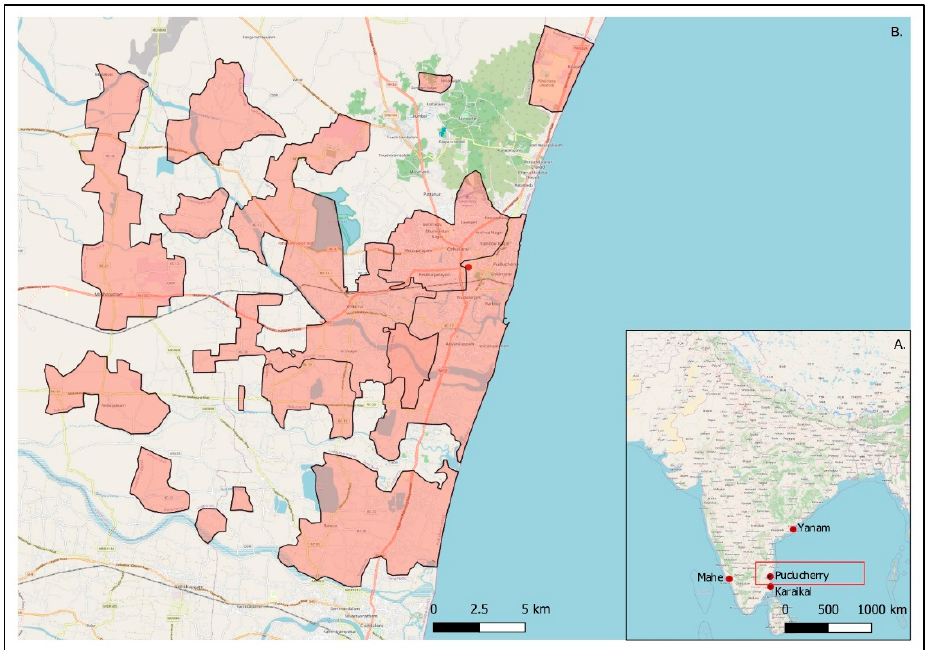
Figure 1. Map of Puducherry. ( A ) Location of the four districts that make up the Union Territory of Puducherry, namely Puducherry, Karaikal, Mahe and Yanam, spread out on either side of the coast of India. ( B ) Puducherry district, which is nestled within the state of Tamil Nadu with Andra Pradesh to the north (inlaid map). The shaded area highlights the non ‐ continuous geographical area of Puducherry district.